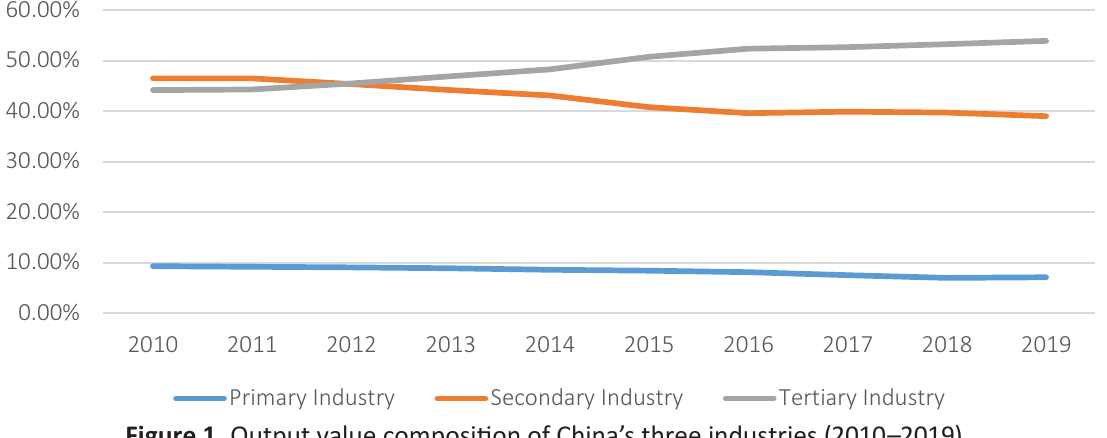
Figure 1. Output value composition of China’s three industries (2010–2019)